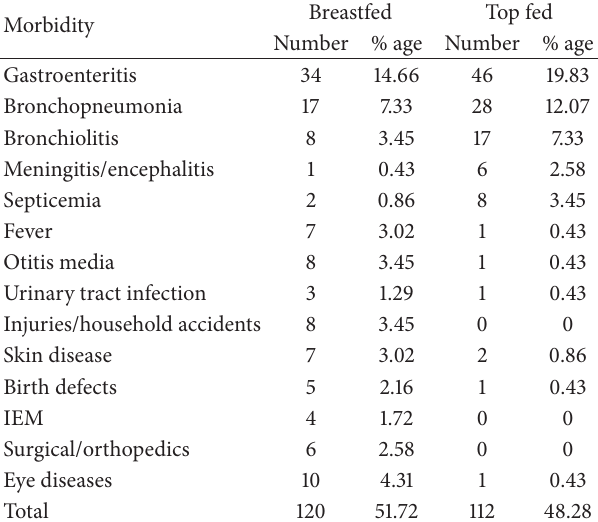
Table 4: Showing correlation of morbidity pattern and feeding pattern (breastfed versus top fed) in infants up to 6 months of